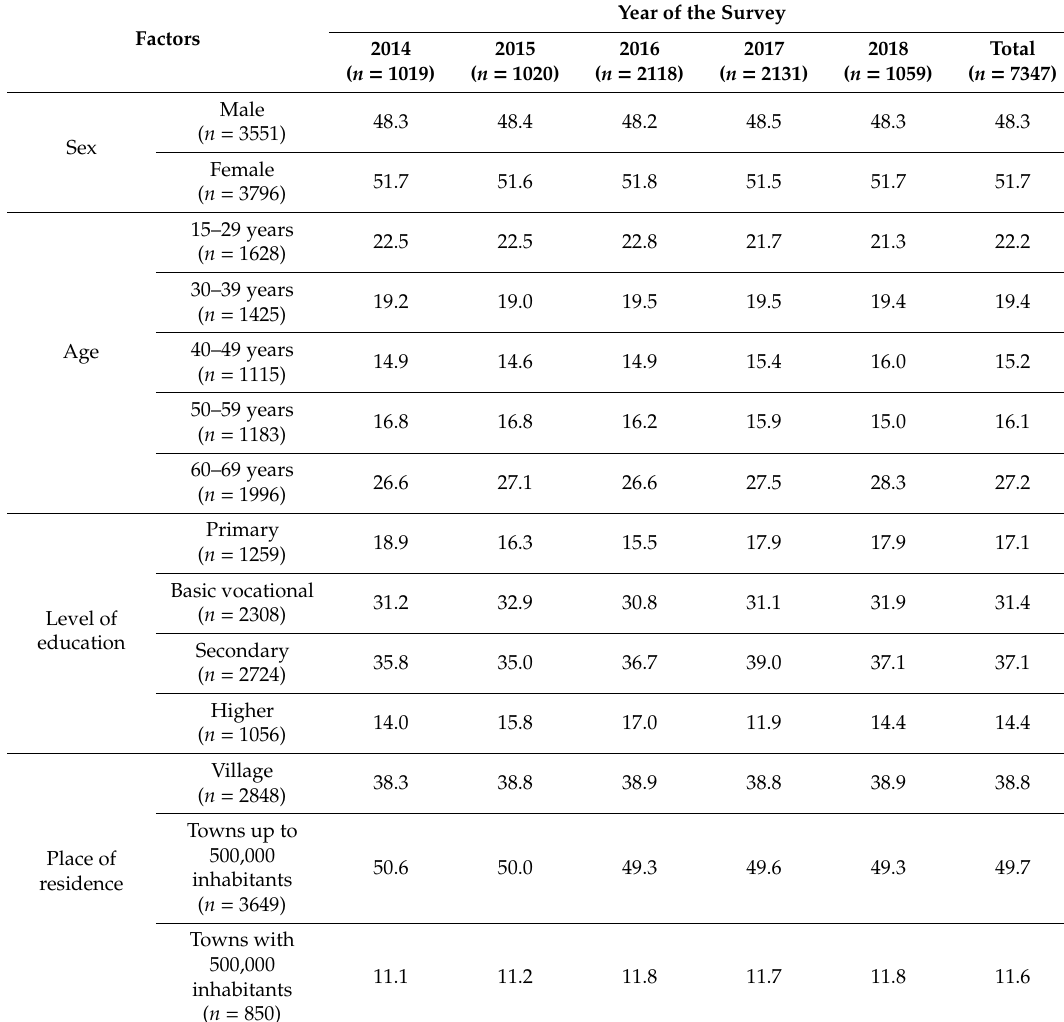
Table 1. Characteristics of the samples in